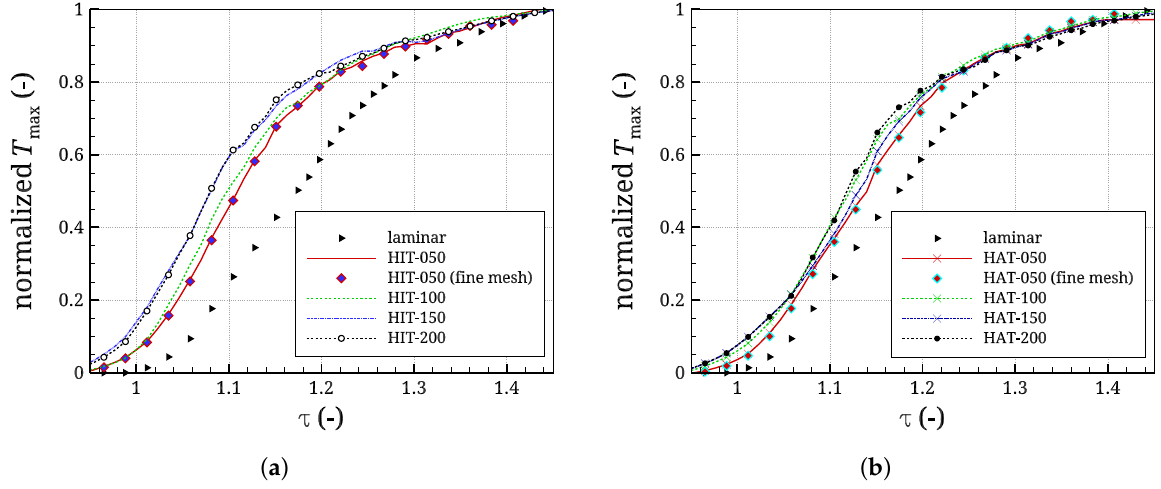
Figure 9. Time evolution of the normalized maximum temperature in the conditions: ( a ) HIT; ( b )